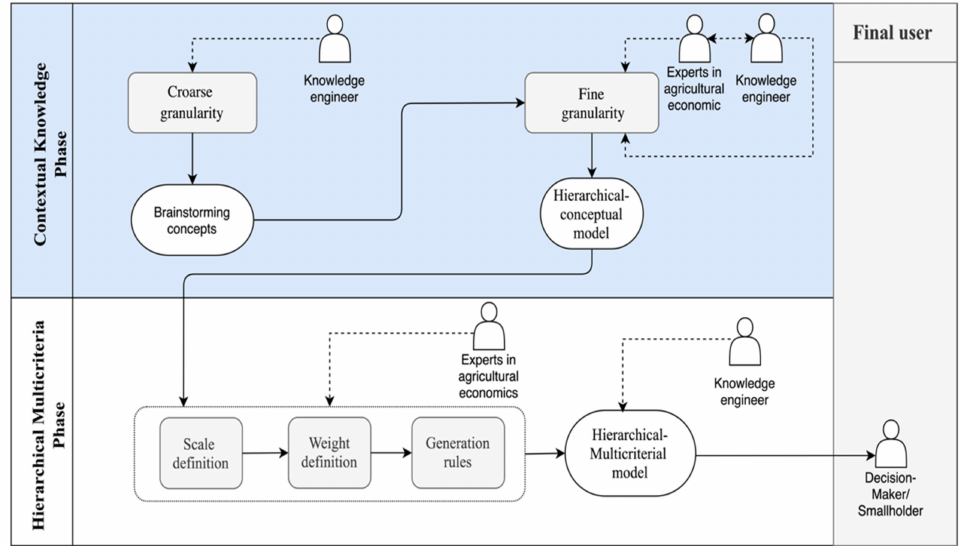
Figure 2. Conceptual process to build the HMP-Coffee model. Phase 1: Contextual knowledge; Phase 2: Hierarchical-